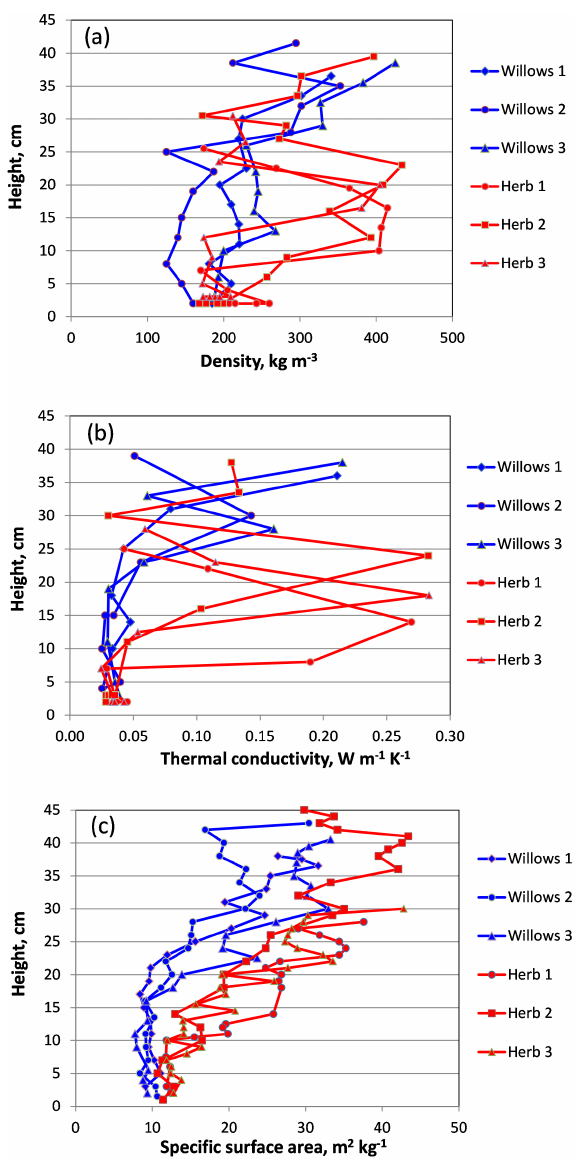
Figure 5. Comparison of physical properties of snow in three pits, each in the large willow patch and on herb tundra. (a) Density; (b) thermal conductivity; (c) specific surface area. In the basal depth hoar, several measurements were sometimes made at the same height because of visible lateral